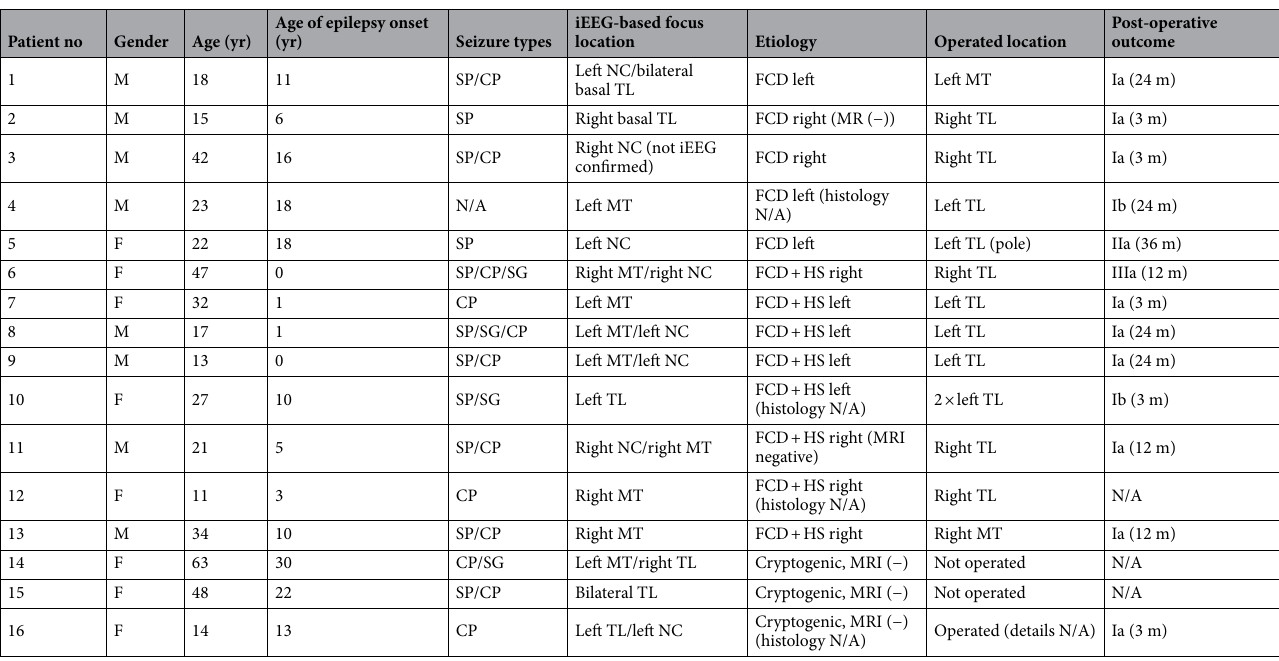
Table 1. Clinical and demographic characteristics of Group A. M male, F female, seizure types: SP focal onset with preserved awareness (“simple partial”), CP focal onset with impaired awareness (“complex partial”),